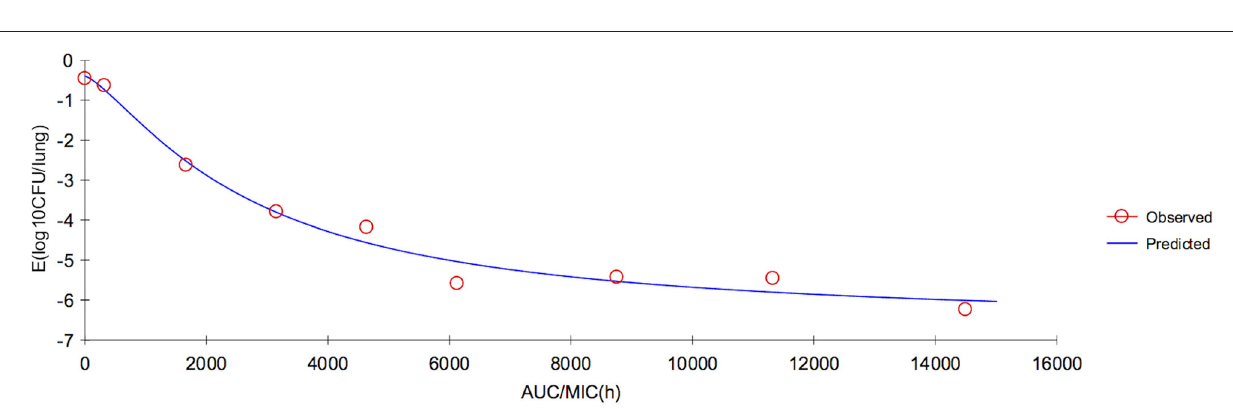
FIGURE 5 | Sigmoid E max relationship between anti- Haemophilus parasuis effect ( E , log 10 CFU/lung) and in vivo AUC 168 /MIC ratio against H. parasuis in the lung tissues of guinea pigs.